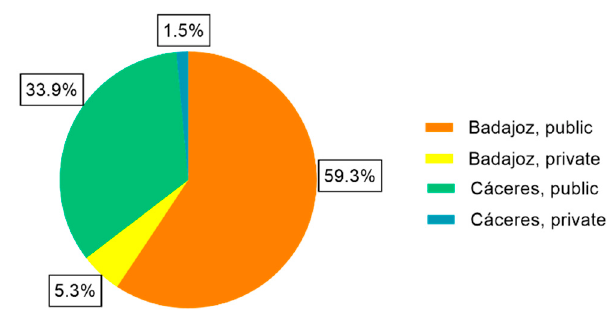
Figure 3. Proportion of thermal energy generated based on province and type of management.